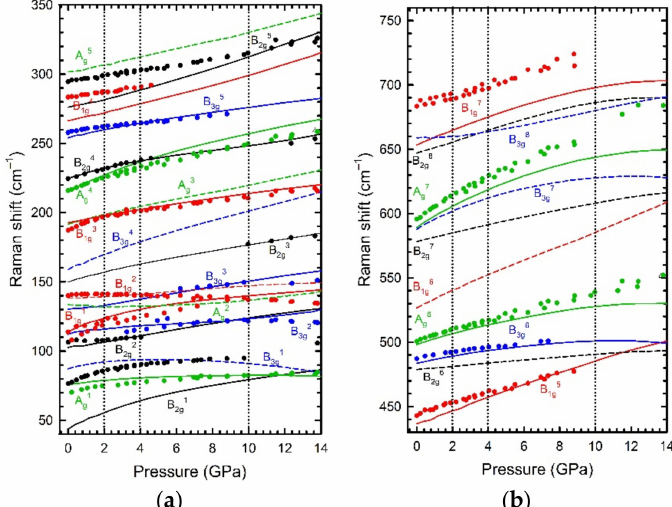
Figure 4. Experimental (symbols) and theoretical (lines) pressure dependence of the Raman-active frequencies of β -Sb 2 O 3 . Low frequency range ( a ) and high frequency range ( b ). Solid (dashed) lines correspond to experimentally observed (non- observed) Raman-active modes. Vertical dotted lines are guides to the eye to help to identify the changes in the Raman-active